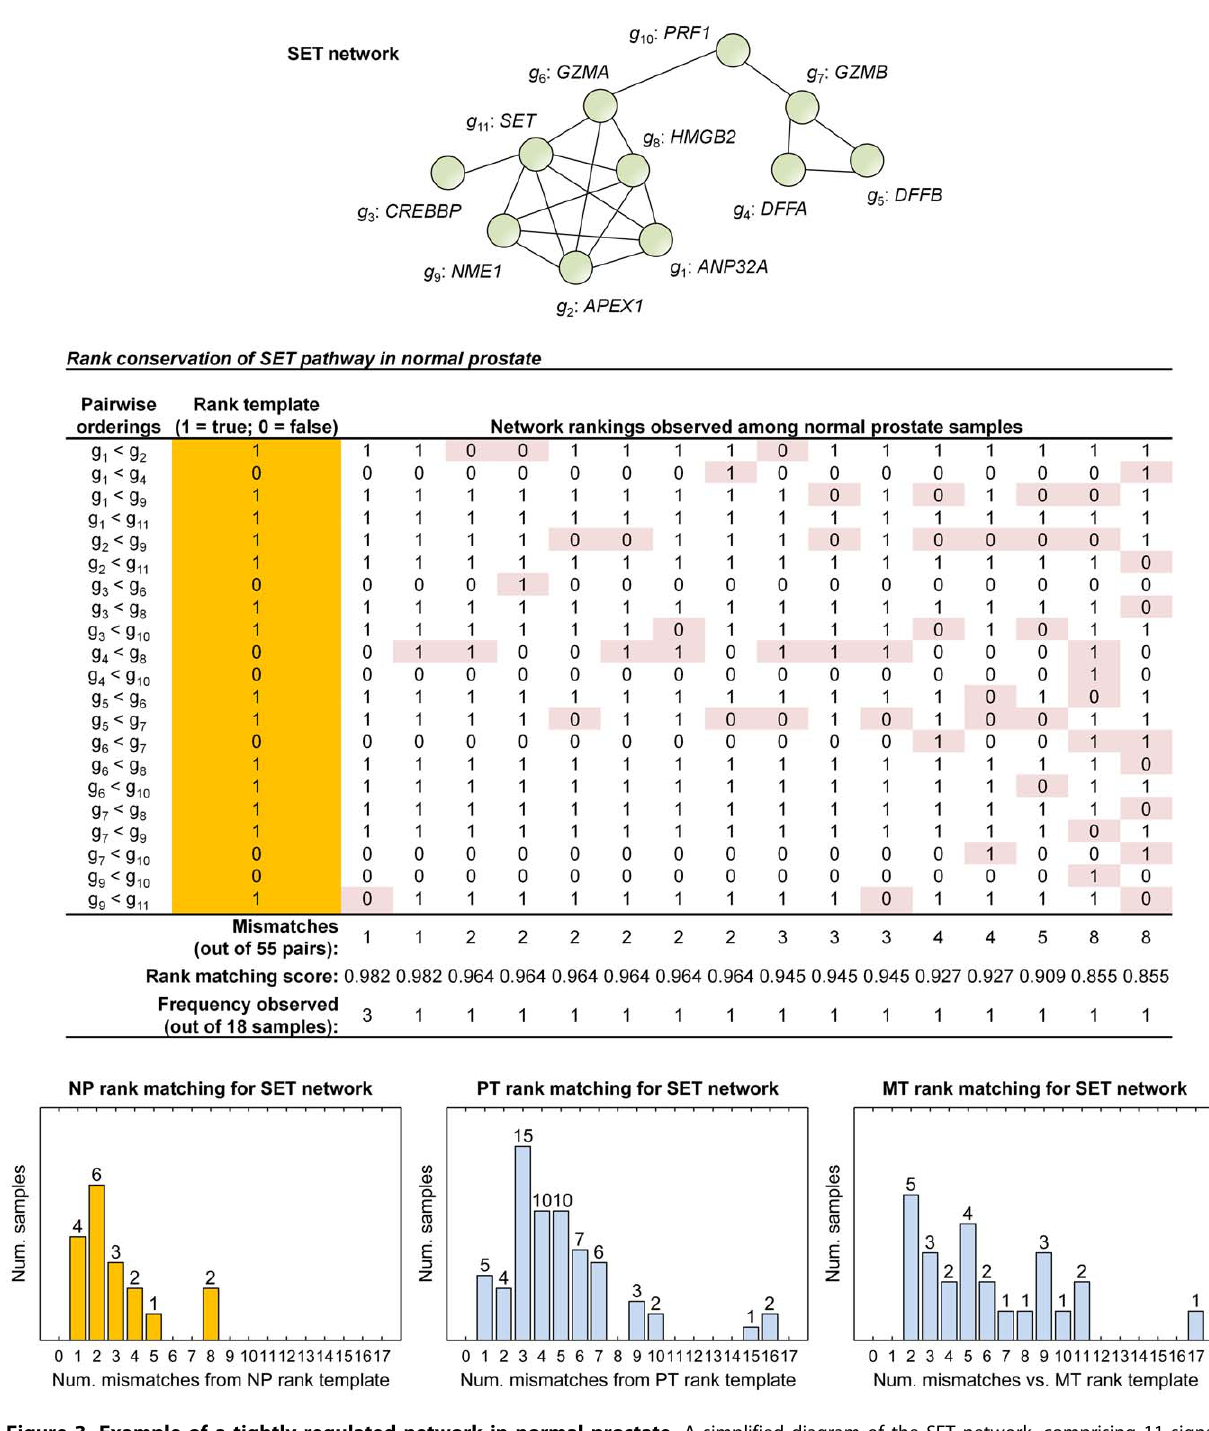
Figure 3. Example of a tightly regulated network in normal prostate. A simplified diagram of the SET network, comprising 11 signaling proteins involved in granzyme mediated apoptosis, is shown in the center. The NP rank template for the network is highlighted yellow, and each unique ranking observed in NP samples is shown to the right with mismatches highlighted red. The histograms at the bottom demonstrate the increased variation in ranking in PT and MT, indicated by greater number of mismatches from the respective rank